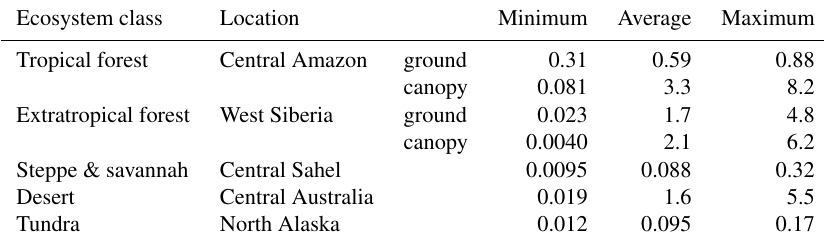
Table 2. Simulated nitrous oxide emissions by lichens and bryophytes in (mgN 2 O)m − 2 year − 1 for individual grid cells of the LiBry model. The values are averages over the last 50 years of a 600-year simulation with 3000 initial species. Grid cells are selected from five different ecosystem classes. In the two forest classes, emissions are separated into canopy and ground. In the other classes, the model does not represent lichens and bryophytes in the canopy. The range of N 2 O emissions based on all surviving artificial species in a grid cell is shown. The average value for all species in a grid cell is derived by an NPP-based weighting scheme (see Sect.